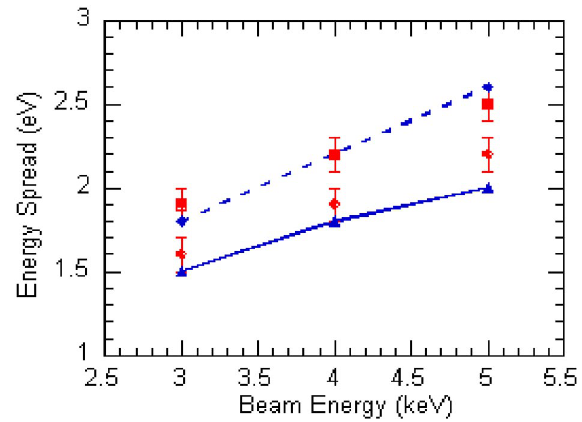
FIG. 10. (Color) Beam energy spread along beam pulse for a beam with energy of 5 keV and current of 135 mA. Average energy spread of the main beam is 2.2 eV.